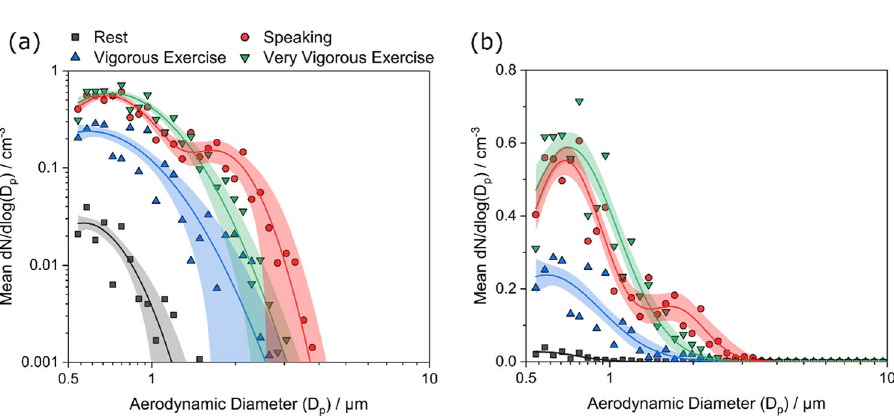
Fig. 3 Aerosol size distributions (0.54 – 20 µ m) for breathing at rest and during exercise, and while speaking. Comparison of average size distributions from speaking at 70 – 80 dBA (red circles), breathing at rest (black squares), and during vigorous (blue triangles) and very vigorous (green triangles) exercise across n = 25 participants. Corresponding log-normal fi ts for each activity are shown by curves of the same colour, with shaded areas representing the 95% con fi dence interval of the fi t. Data depicted on log base 10 ( a ) and linear ( b ) scales. dBA A-weighted